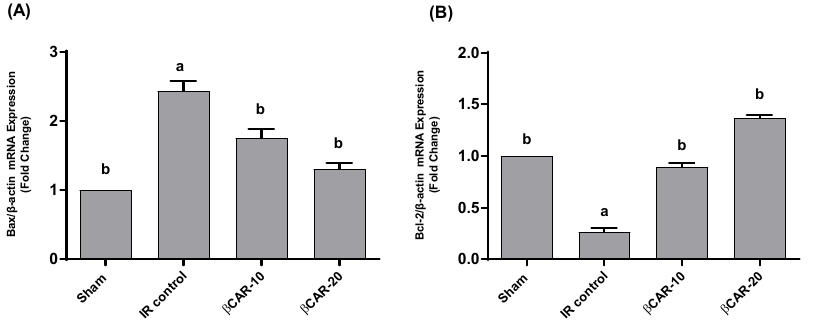
Figure 8. Effect of beta -carotene on caspase-3 protein expression in cerebral cortex of focal cerebral ischemia-reperfusion model × 200. Caspase-3 immunopositive cell was with dark brown cytoplasmic and nuclear color (arrows). ( A ) Sham group, ( B ) I/R control group, ( C ) βCAR -10 group, and ( D ) βCAR -20 group. Scale bar 50 µm.